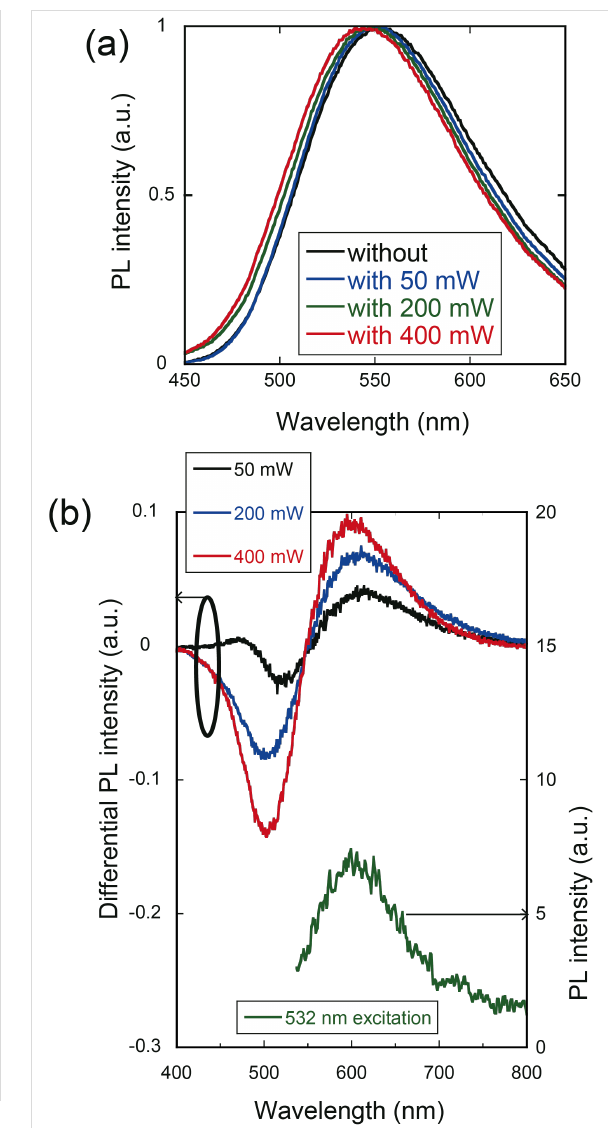
Figure 4: (a) PL spectra obtained with 532 nm light ( λ 2 ) and different levels of irradiation power. (b) (Left vertical axis) Differential PL spectra calculated from spectra obtained with and without irradiation. (Right vertical axis) PL spectrum of ZAIS nanocrystals grown without laser ir- radiation. The PL spectrum was obtained by using 532 nm